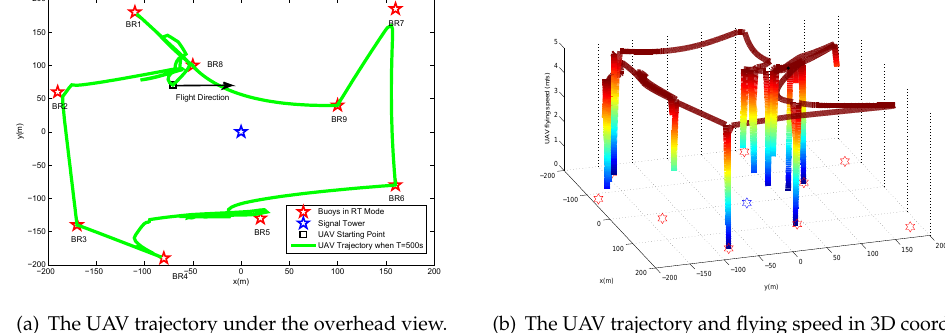
Figure 5. The optimized UAV trajectory and flying speed when T = 500 s, B k [ 0 ] = 0.